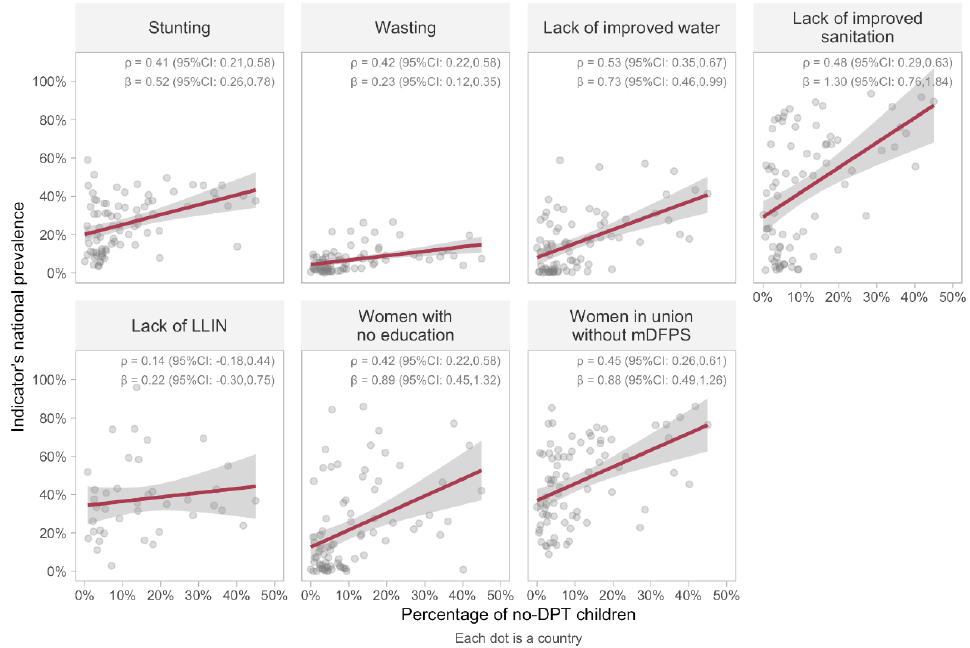
Figure 2. Associations between no-DPT prevalence and prevalence of deprivation indicators in 80 countries (39 countries for bed nets). Linear regression lines are shown in red, and 95% CI in grey. ρ: Spearman correlation coefficient. Legend: DPT: diphtheria, pertussis, tetanus. LLIN: long-lasting insecticidal nets. mDFPS: demand for family planning satisfied with modern methods. CI: confi- dence interval.